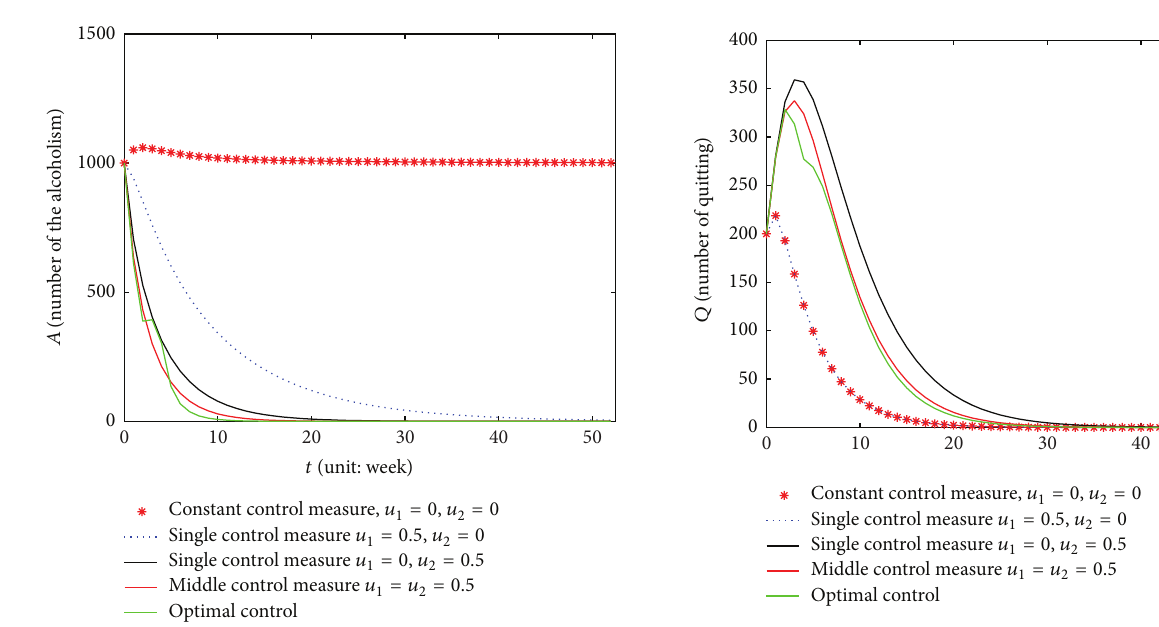
Figure 8: Number of people in quitting compartment when we choose the weights in objective function are 𝑐 1 = 10 2 ; 𝑐 2 = 10 4 and underdifferentoptimalcontrolstrategies,thatis,(1)withoutcontrol: = 𝑢 = 0 ; (2) single control: 𝑢 = 0.5 , 𝑢 = 0 ; (3) single control: 𝑢 1 2 1 2 = 0 , 𝑢 = 0.5 ; (4) middle control: 𝑢 = 𝑢 = 0.5 ; (5) optimal 𝑢 1 2 1 2 control: 𝑢 1 = 𝑢 ∗ 1 , 𝑢 2 = 𝑢 ∗ 2